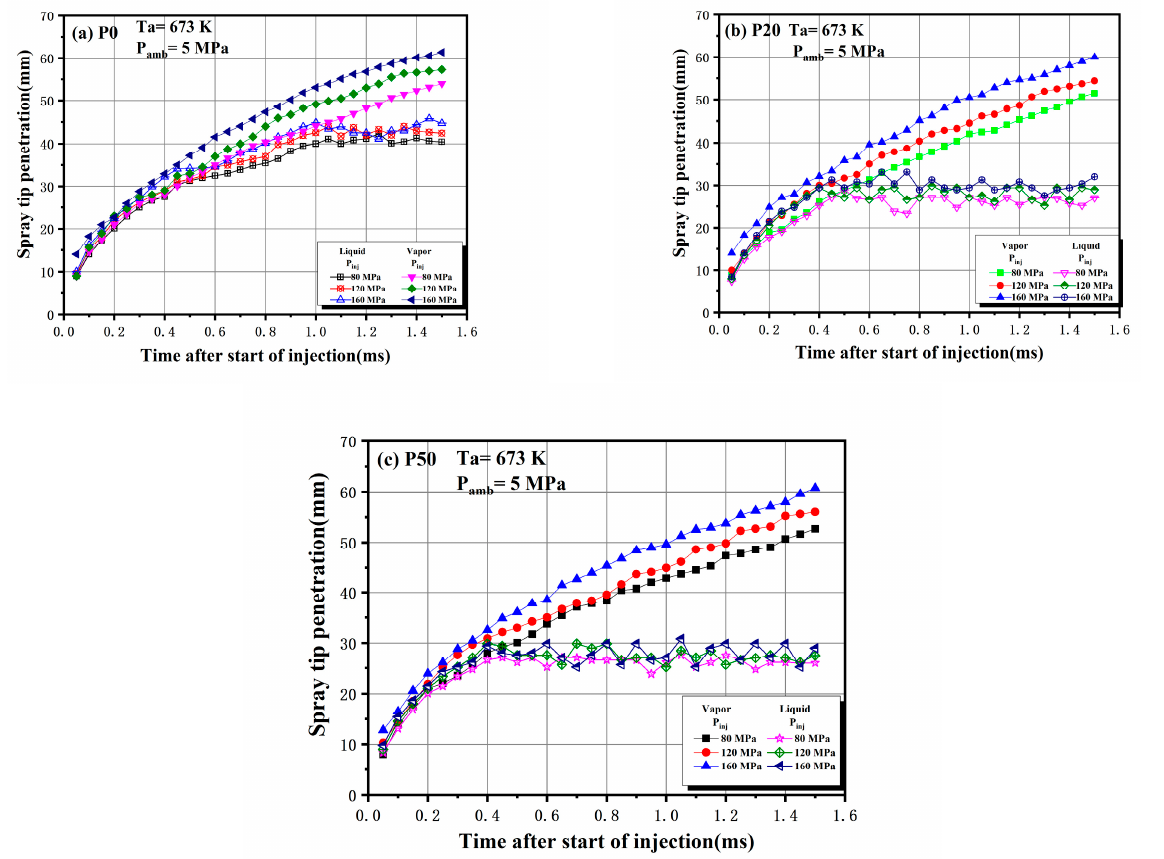
Figure 11. Penetration distances of the three fuels under different IPs: ( a ) P0, ( b ) P20, ( c ) P50.